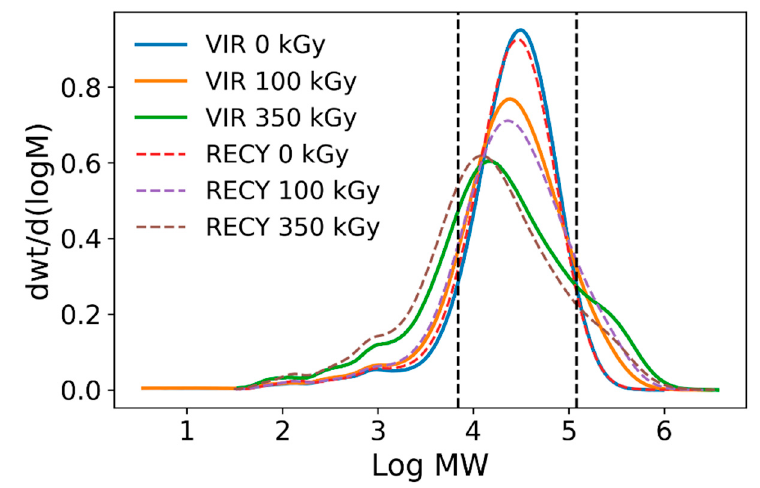
Figure 10. Plots of the molecular weight distributions obtained from GPC.